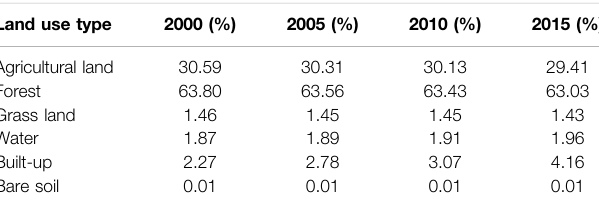
TABLE 1 | Area percentage statistics of land use